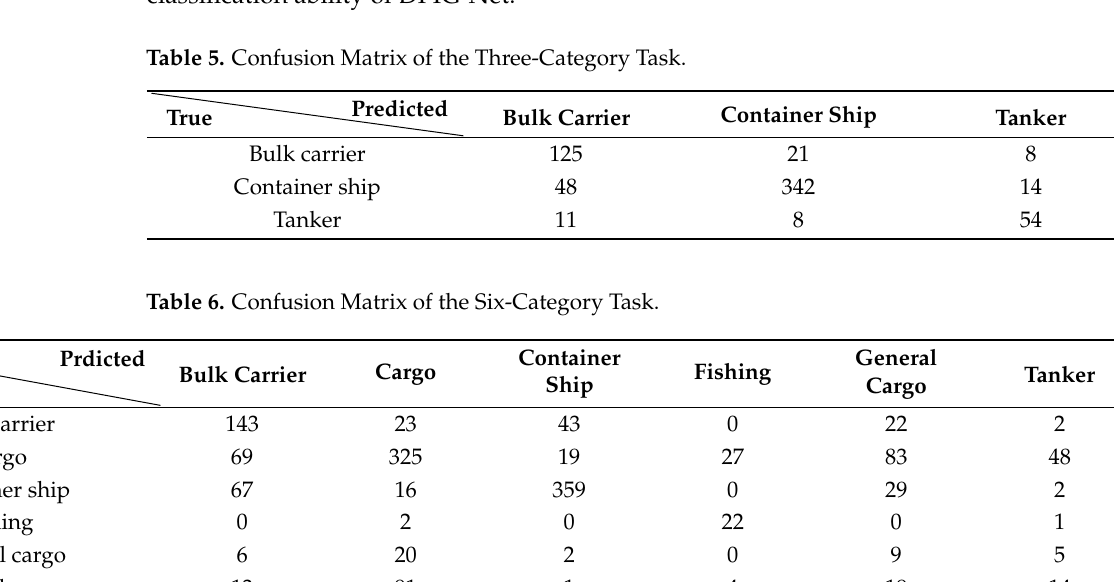
Table 5. Confusion Matrix of the Three-Category Task.